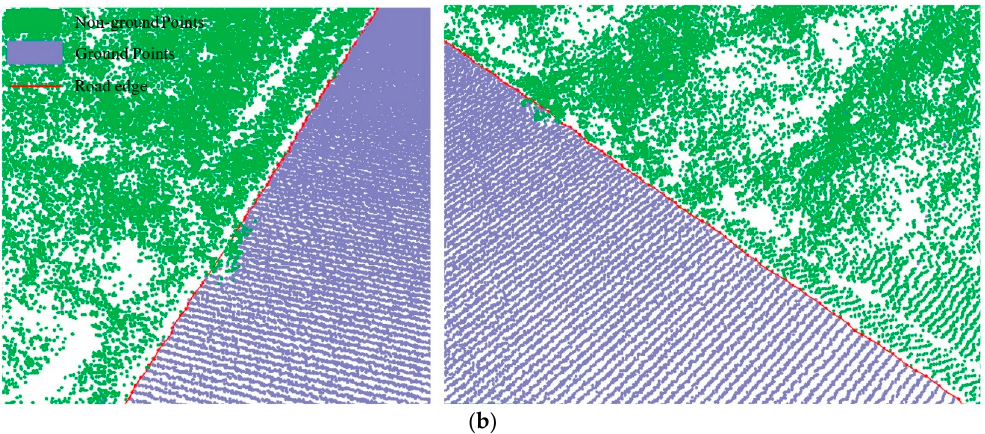
Figure 11. Extraction results for ground and curb points along a grass-soil road type. ( a ) Road edge points for grass-soil road; ( b ) Road edge for grass-soil road.